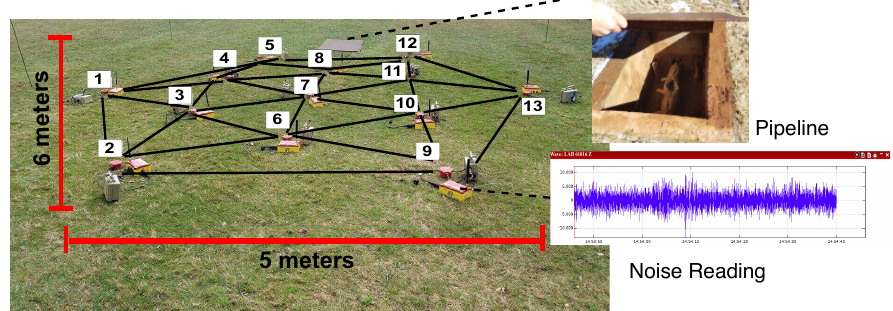
Figure 17. Deployment real location. A pipeline is located under the S3N location. Every node automatically started to read and cross-correlate the ambient noise. The distance between nodes was 3 m (9.843 ft.) from the center to the outside circle nodes, and 1.7 m (5.577 ft.) from the center to the inside circle nodes.